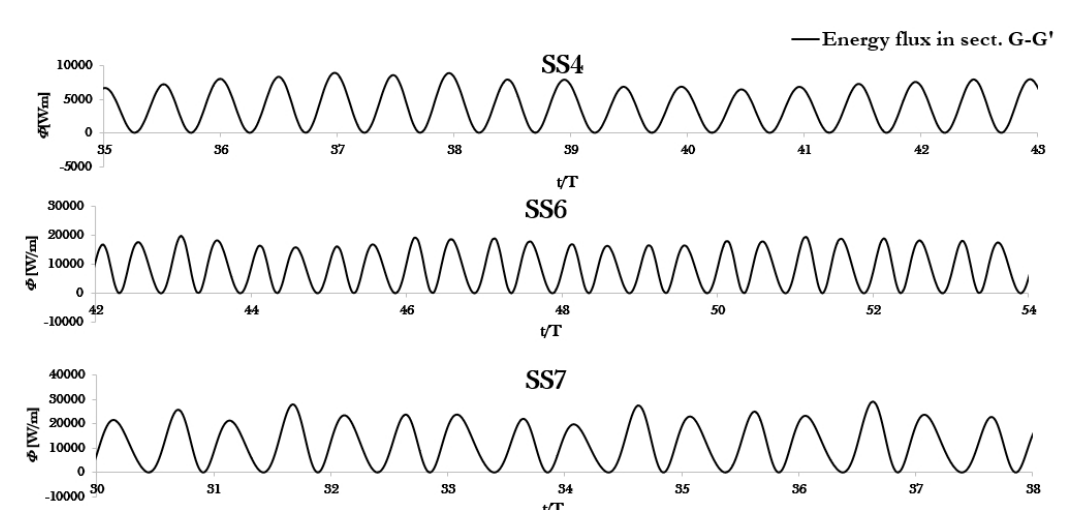
Figure 17. Time histories of the pneumatic power absorbed in the porous medium reproducing the air turbine characteristics.